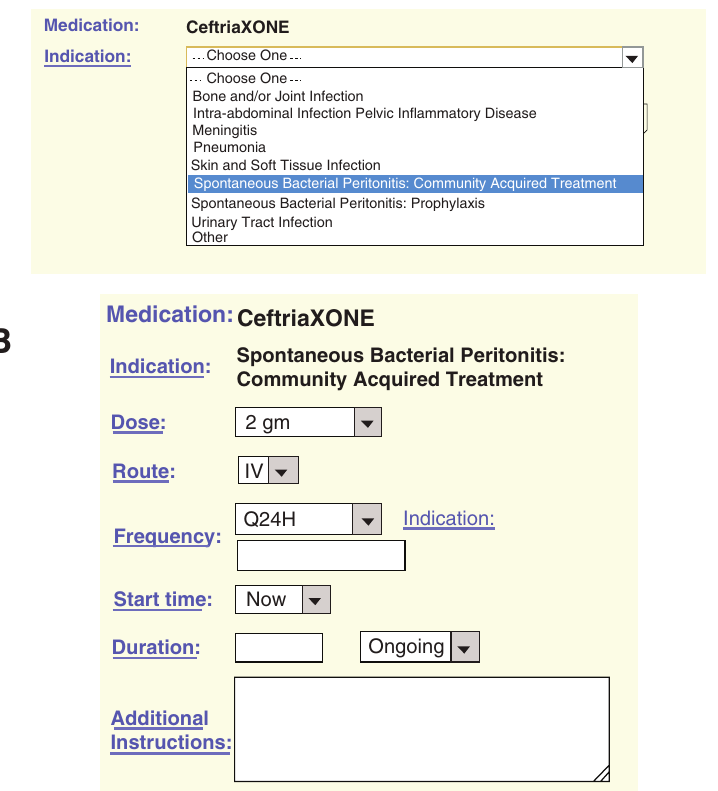
Figure 2. Modified provider order entry standardizes treatment of spontaneous bacterial peritonitis. A . When an ordering physician chooses ceftriaxone, an indication must be chosen. B . When spontaneous bacterial peritonitis is the chosen indication, the preset dose is 2 g daily.